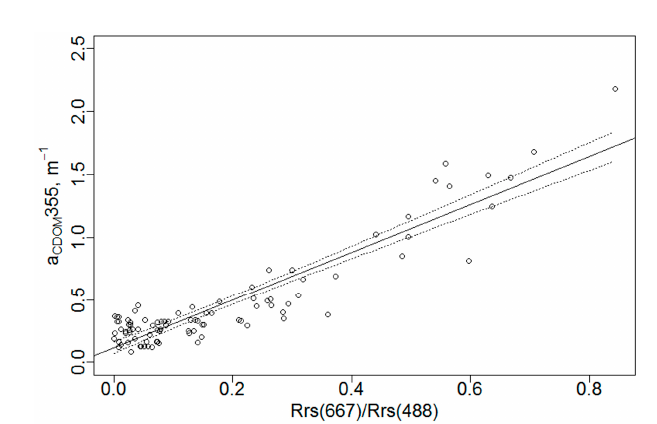
Figure 4. Plot of the in situ a CDOM 355 values versus the in situ band ratio R rs (667)/ R rs (488) of the test data set. The solid and dashed lines are the OLS fitted Model 1 and the 95% confidence interval, respectively.